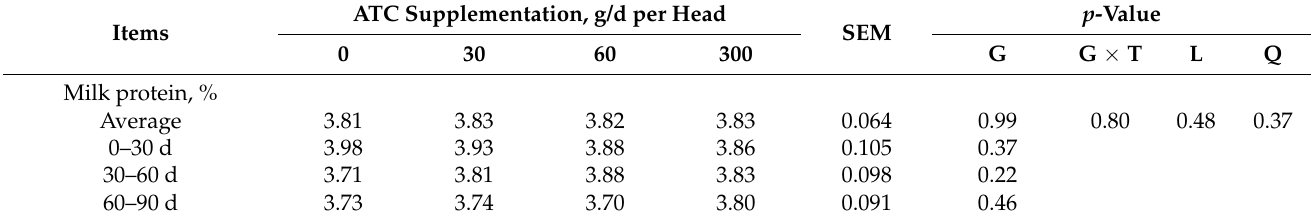
Table 3. Effects of different amounts of Acremonium terricola culture on milk composition in lactating dairy